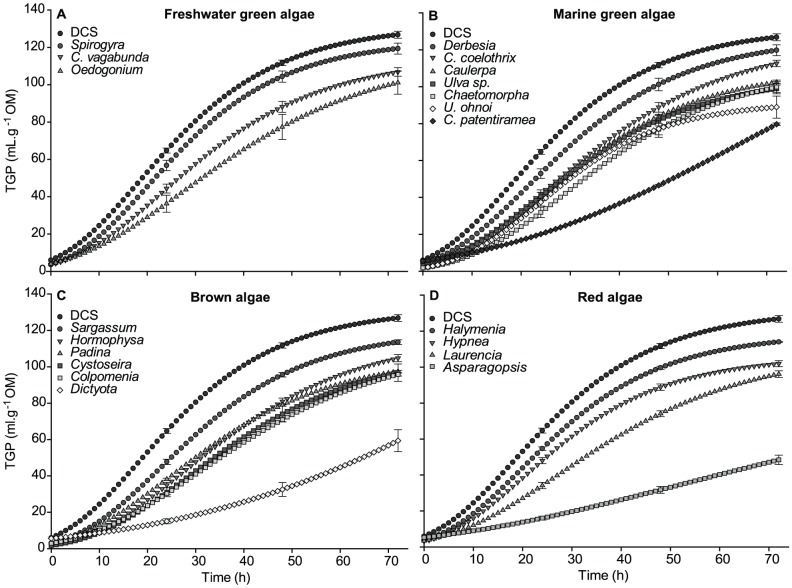
Total gas production of macroalgae species over the 72 h incubation period.Error bars represent ±SE (n = 4). Species full names are given in Table 1.